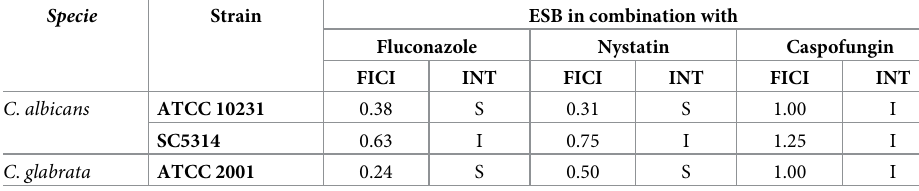
Table 2. Effect of E . senegalensis stem bark extract on the antifungal activity of fluconazole, nystatin and caspofungin.